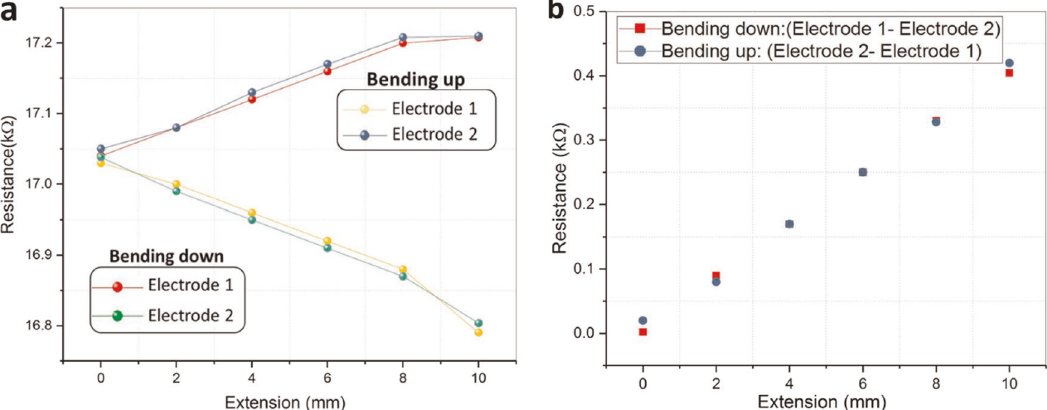
Fig. 7 a The responses of a double-sided LIG sensor to bending with the LIG under tension and compression states. b The results of difference measurements